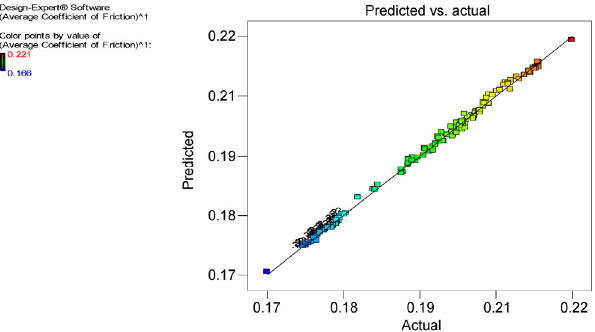
Fig. 12 Predicted versus actual response values for the average coefficient of friction.